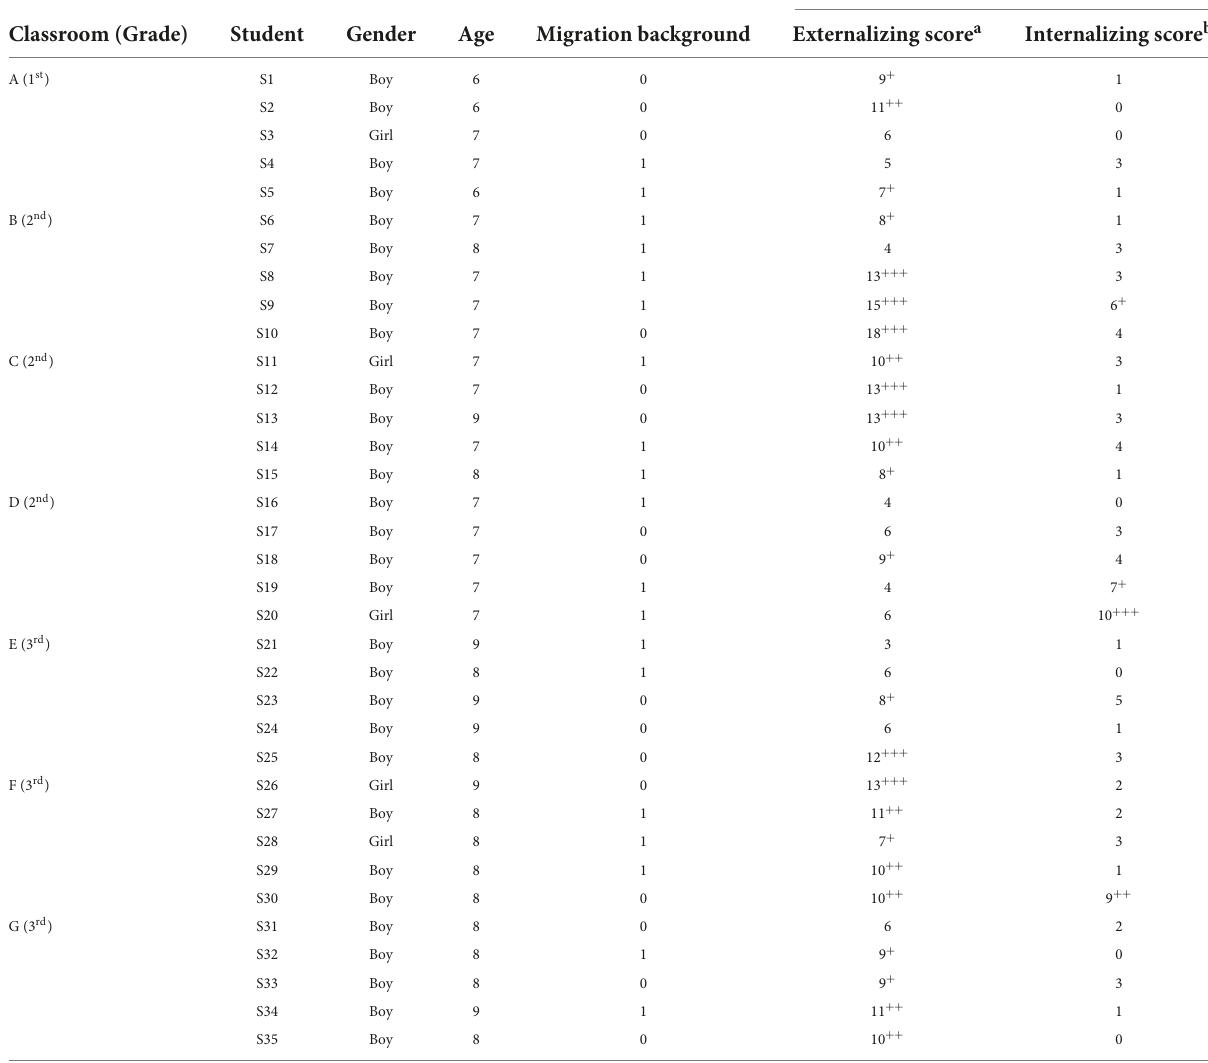
TABLE 1 Student demographic information and data of the behavioral screening instrument